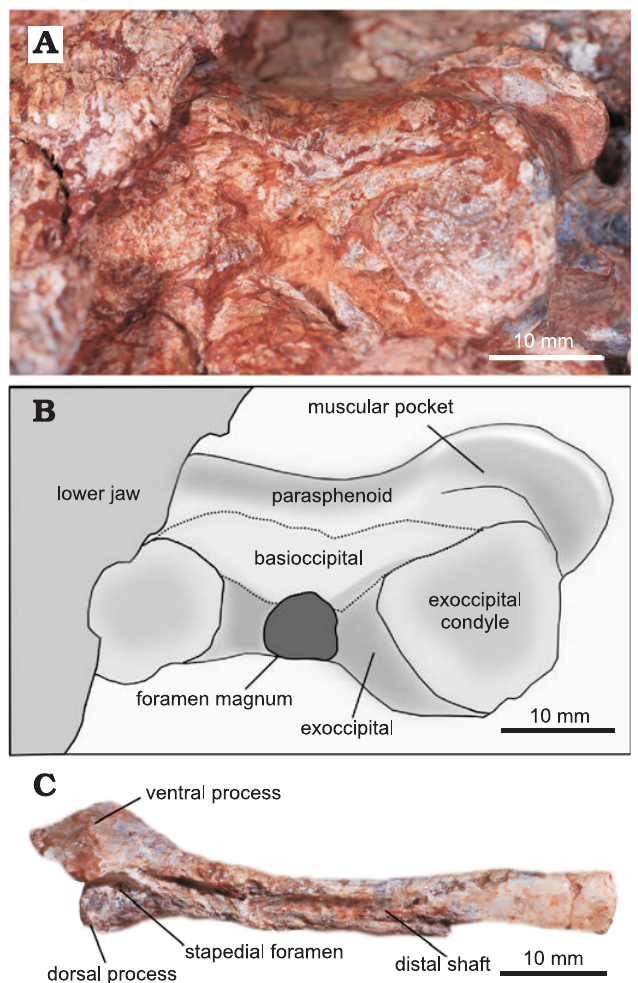
Fig. 5. Cranial elements of stereospondylomorph temnospondyl Para- pytanga catarinensis gen. et sp. nov. (holotype, UFRGS-PV-0355-P) from the Santa Catarina State (Brazil), Middle–Upper Permian. Photo ( A ) and interpretative drawing ( B ) of the skull in occipital view. C . Photo of the left stapes in postero-medial